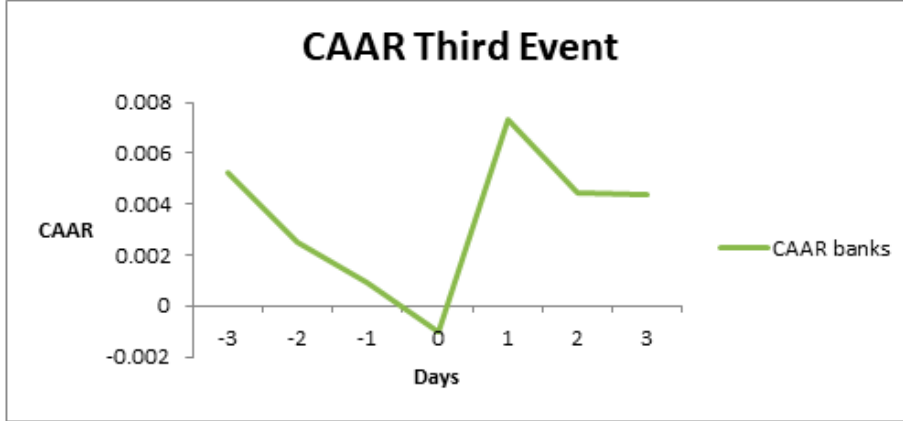
Figure A3. CAARs for banks with the third event. Source: Authors’ Figure A3. C AARs for banks with the third event. Source: Authors’ work. Figure A3. C AARs for banks with the third event. Source: Authors’ work.